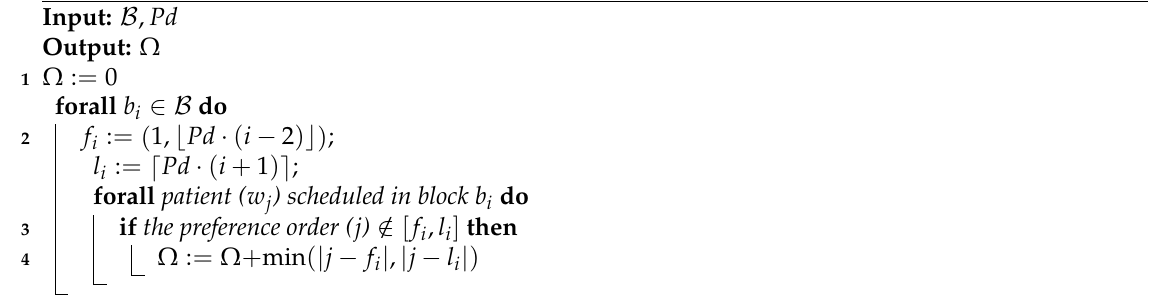
Algorithm 1 Calculation of Ω parameter in a scheduling of |B| time blocks